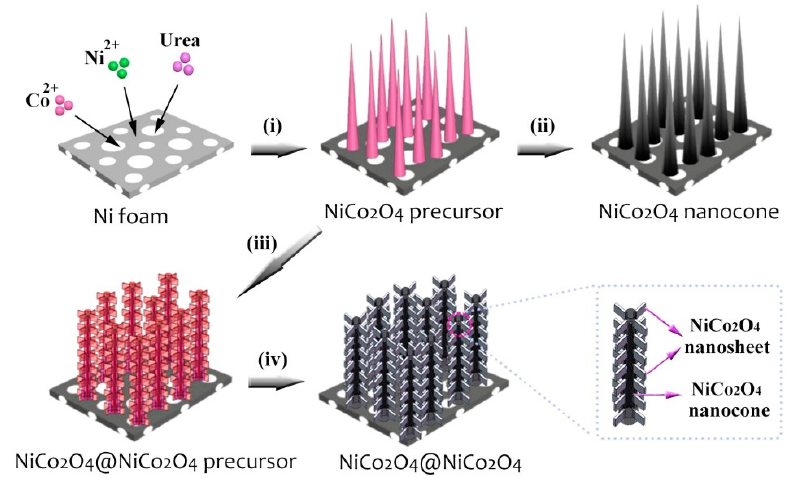
Figure 8. Schematic of the fabrication process for 3D NiCo 2 O 4 @NiCo 2 O 4 hierarchical core-shell NCAs on Ni foam. Reproduced with permission from Xiuhua Wang, Three-Dimensional NiCo 2 O 4 @NiCo 2 O 4 Core-Shell Nanocones Arrays for High-Performance Supercapacitors; published by Elsevier, 2018 [94] .